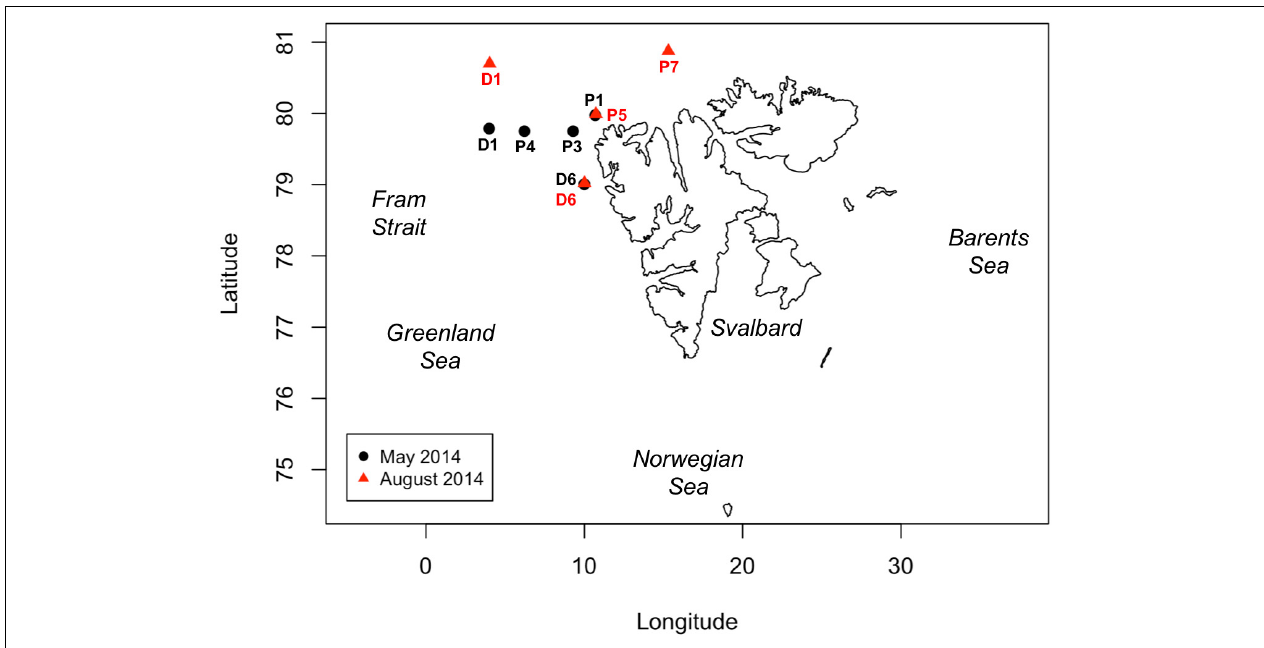
FIGURE 1 | Map of the Svalbard Archipelago, showing the locations of sampling stations occupied in May (stations D1, D6, P1, P3, and P4, black dots) and August 2014 (stations D1, D6, P5 and P7, red triangles). Note that stations P2 and P6 are not included as no data was available for the analysis (see section “Materials and Methods”).